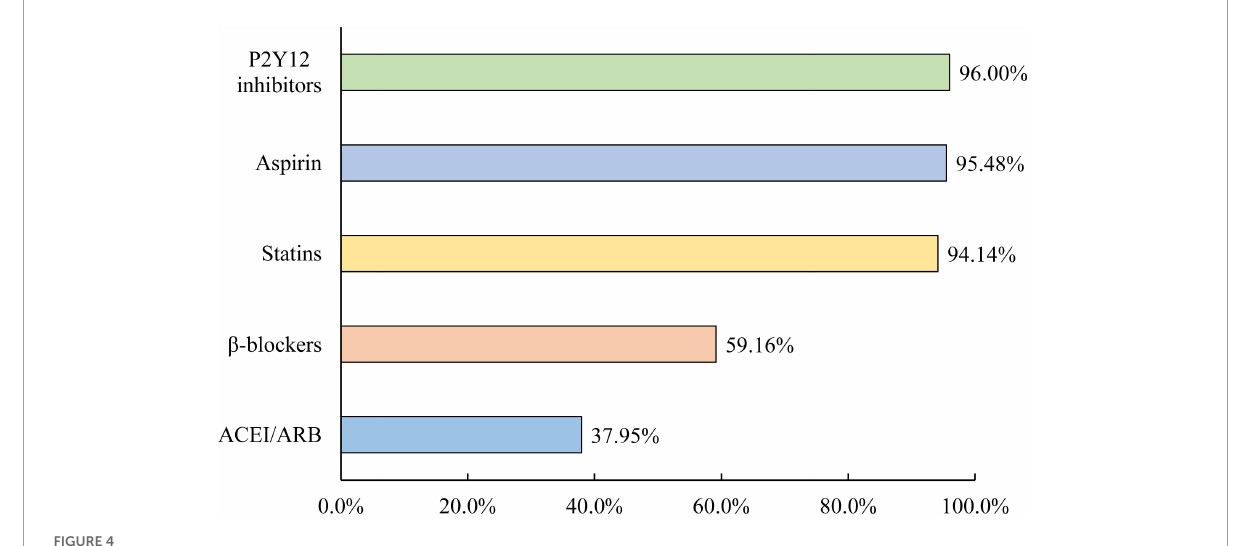
FIGURE4 Discharge mediations for the secondary prevention of